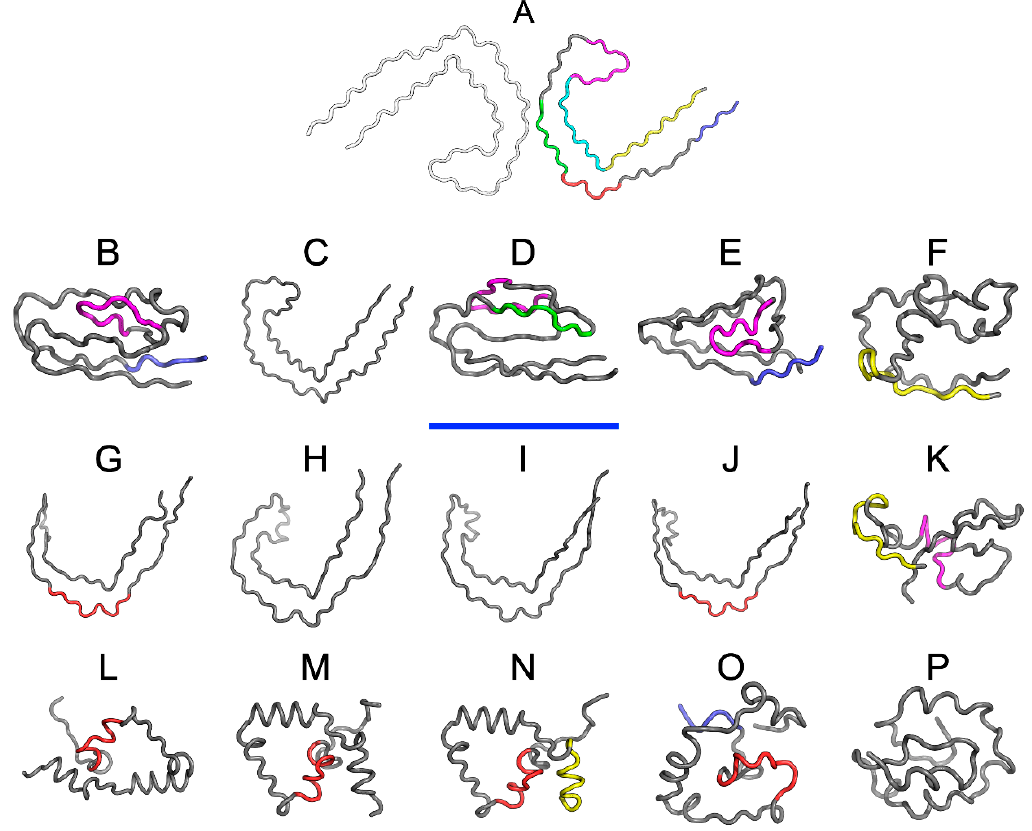
Figure 5. 3D presentation of structures obtained using I-Tasser upper row ( B – F ), Robetta central row ( G – K ) and the fuzzy oil drop (FOD) model bottom row ( L – P ). The top structure ( A ) is the structure phf-tauO as appears in PDB database. The colors used correspond to highlights on Figure 4. Models whose status is consistent with FOD predictions (RD < 0.5) have been additionally underlined in blue ( D , M , N ).